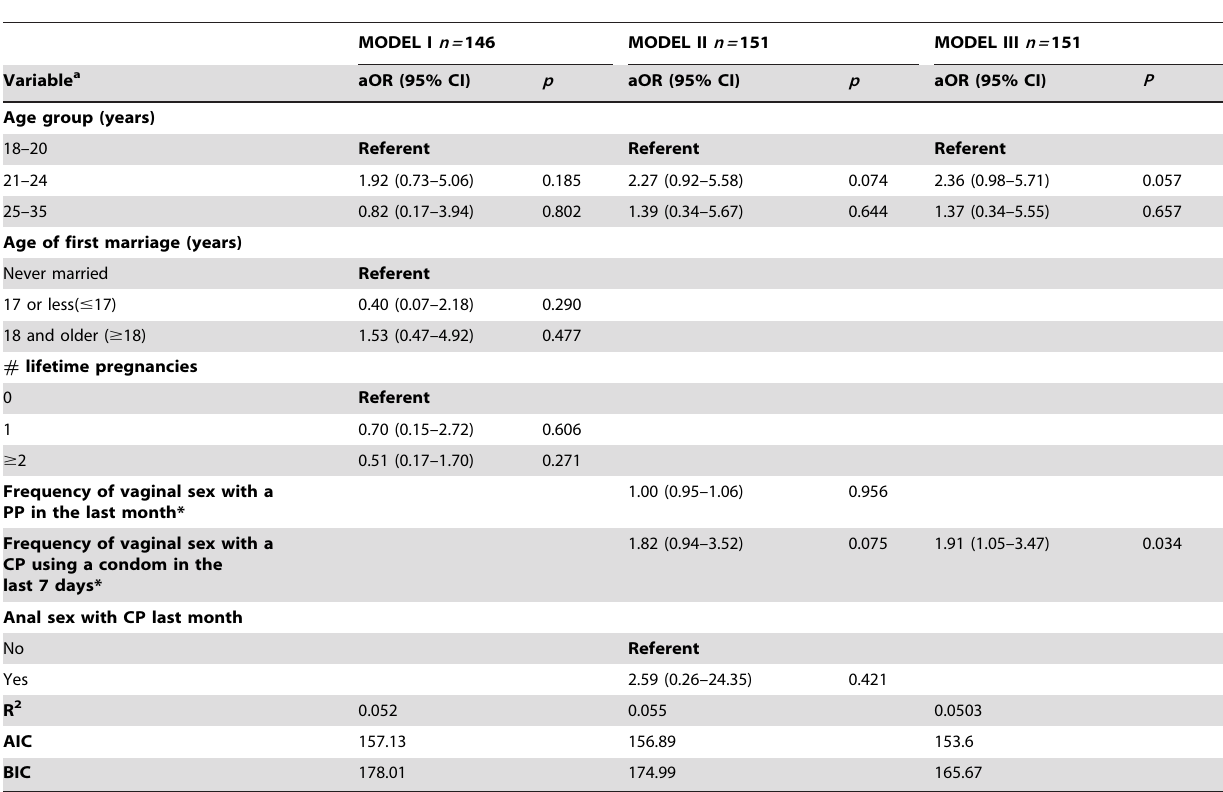
Table 3. Multivariable models of factors associated with HSV-2 incidence in high risk women in Beira,